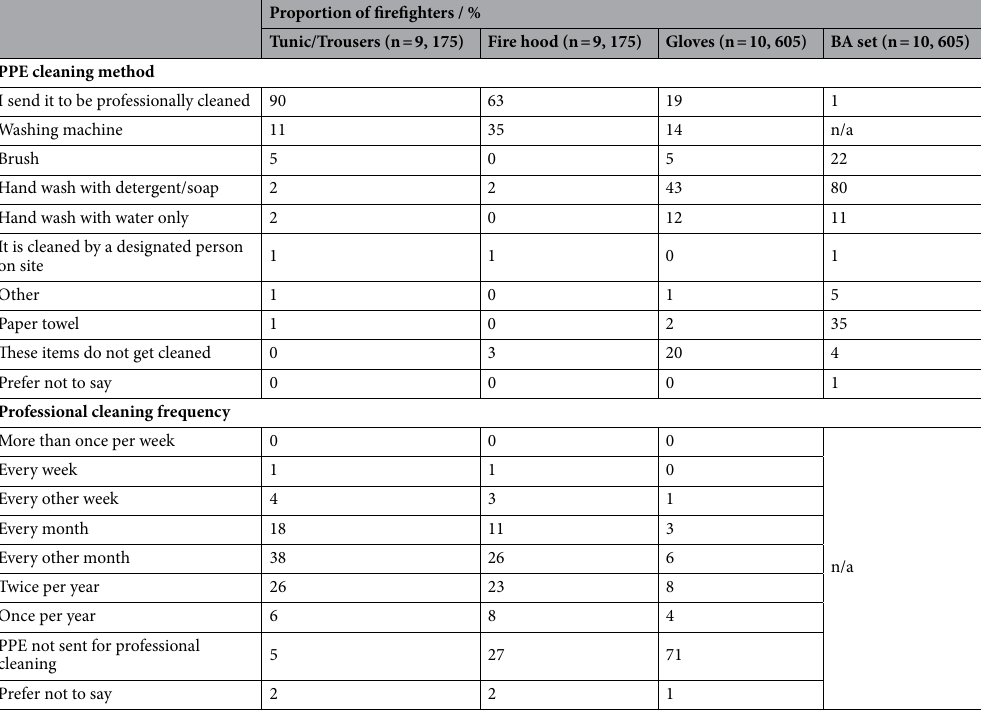
Table 2. PPE cleaning methods and frequency of professional PPE cleaning in the UK Fire and Rescue Service. Firefighters were able to select multiple cleaning methods. Note that only firefighters with individually issued PPE were able to answer questions about the cleaning of tunic/trousers and fire hoods. Fire gloves are issued on an individual basis as standard, thus trends concerning fire gloves represent firefighters with individually issued and pooled stock PPE. It is not (currently) standard practice to send breathing apparatus (BA) for external professional cleaning in the